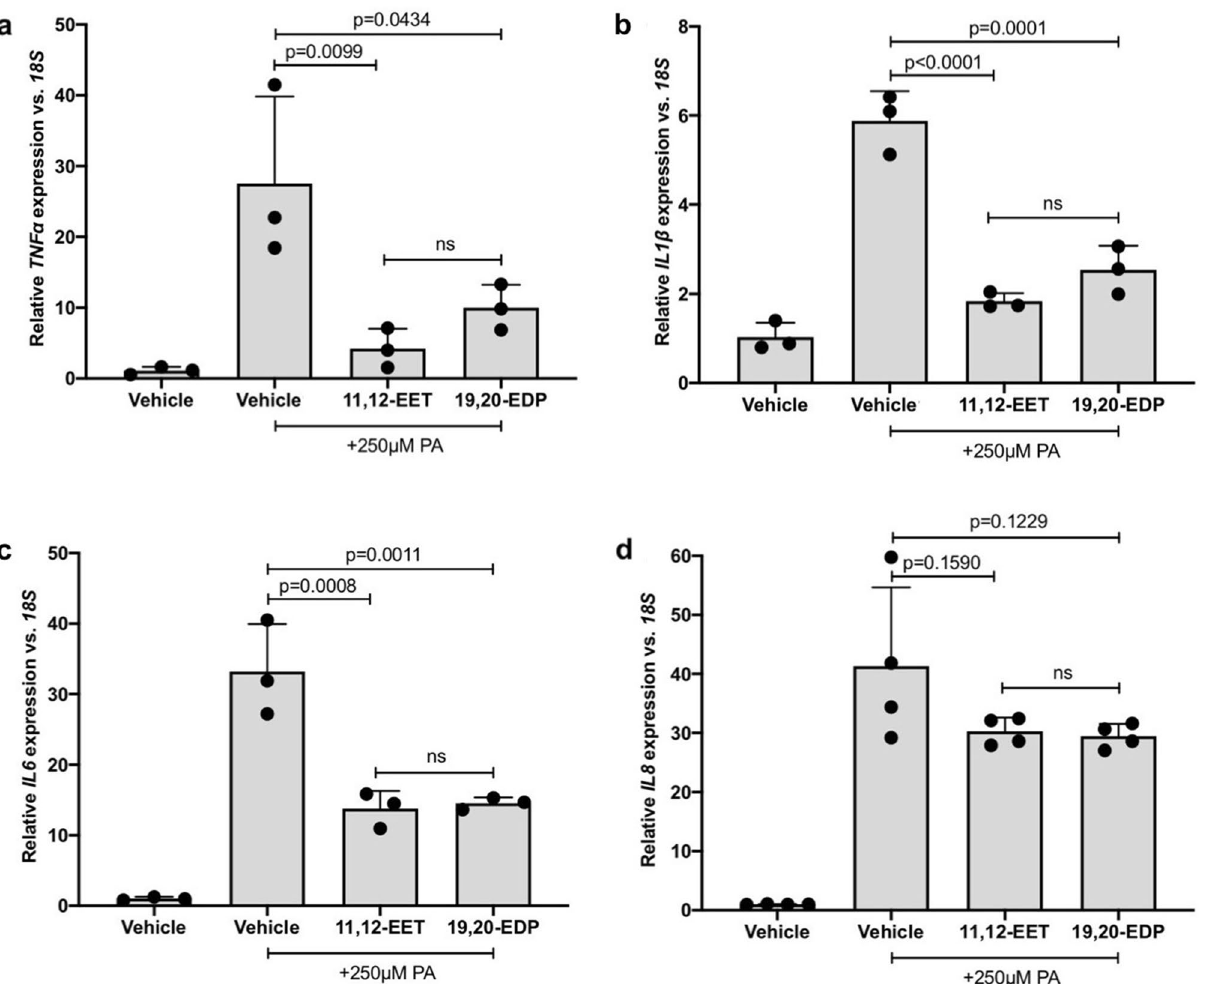
Figure 2. The effect of 11,12-EET and 19,20-EDP on PA-induced inflammatory mediator expression by Müller cells. Human Müller cells were treated with PA (250 μM) for 24 h. 11,12-EET (0.5 μM) or 19,20-EDP (0.5 μM) was added during the final 3 h of treatment. After 24 h, total RNA was isolated and expression was assayed by qRT-PCR. ( a ) TNFα ( b ) IL1β , and ( c ) IL6 expression was significantly decreased by both epoxygenated fatty acids. (d) IL8 expression was reduced but statistical significance was not achieved. Results depicted are representative of three separate experiments. Data are displayed as mean ± SD (n = 3 or 4 for each